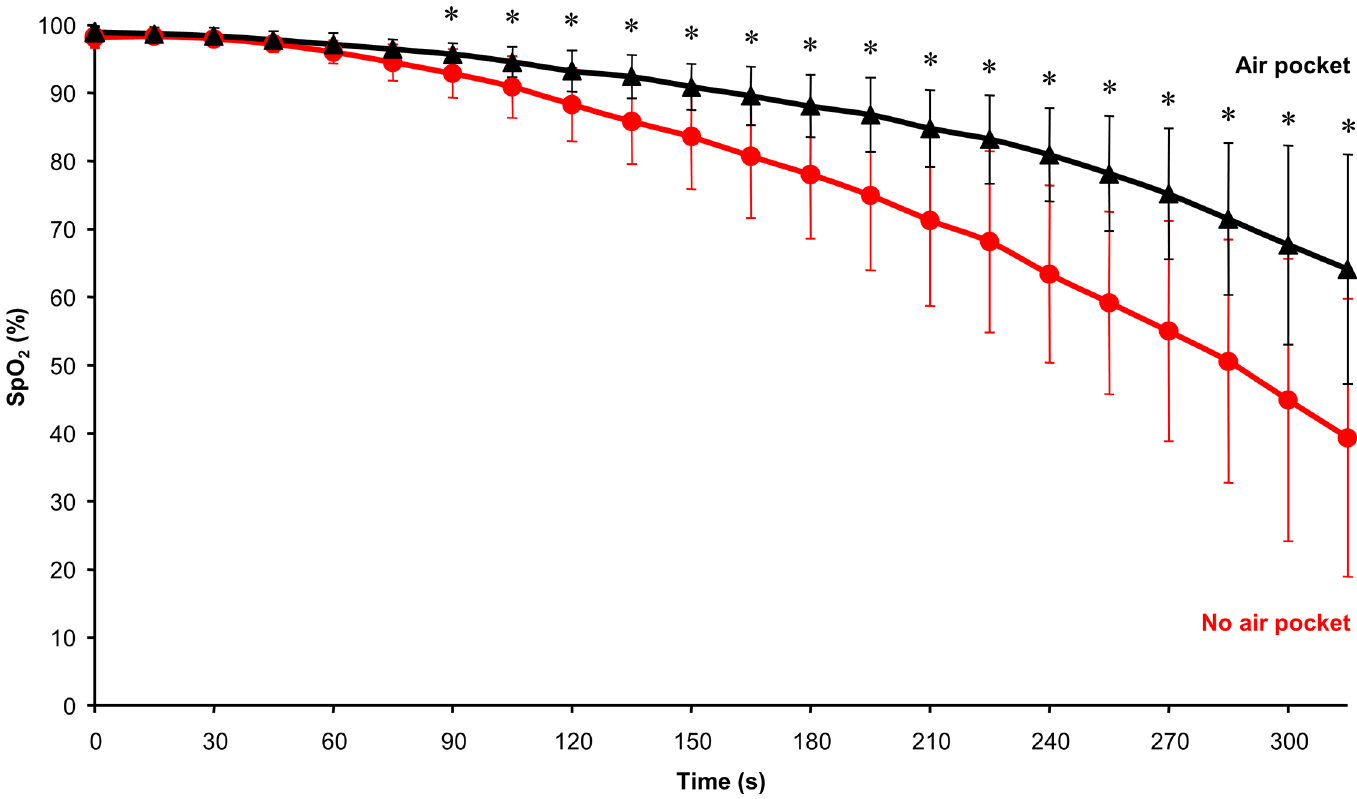
Fig 4. The difference between SpO 2 during NP and AP phases. The symbol * represents statistically significant differences at p (cid:1)